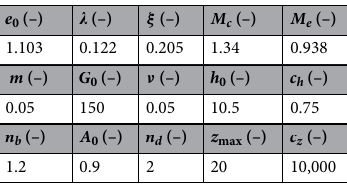
Table 5. Material parameters of SaniSand for KFS from 41